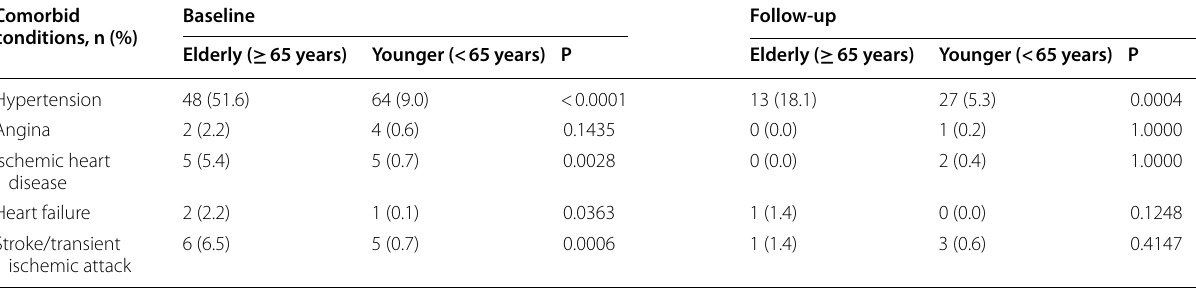
Table 3 Cardiovascular comorbidities at baseline and follow-up